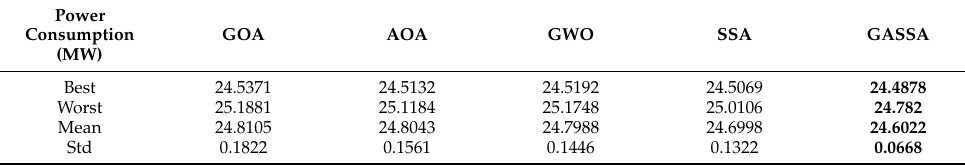
Table 6. Statistics of the results of 30 calculations.